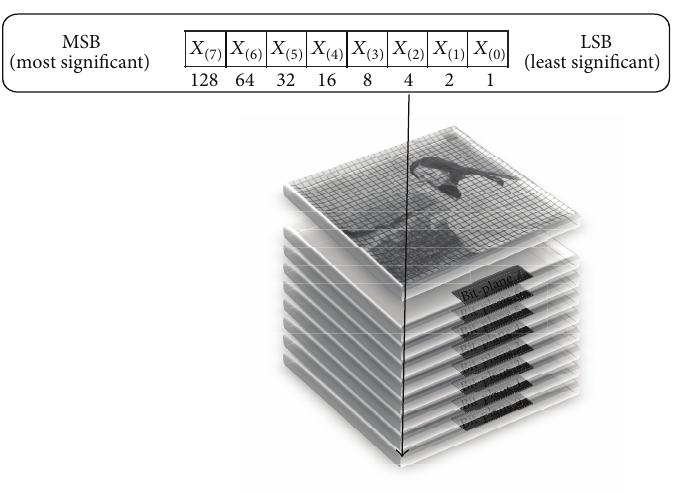
Figure 5: Structure of multimedia sensor data in wireless multimedia sensor networks.